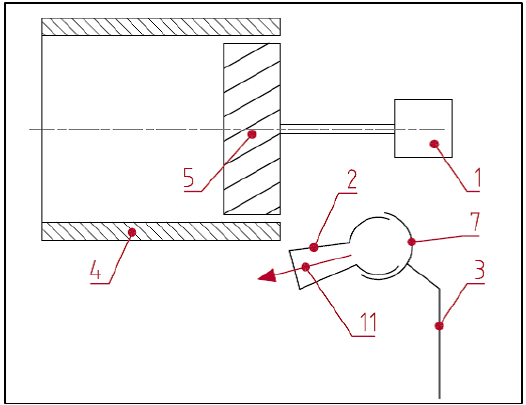
Figure 17. Schematic of a hybrid mesh turbine when switching the operating mode: 1- generator; 2- nozzle block; 3- working gas source; 4- casing; 5- impeller; 7- velocity vector control system; 11- working fluid flow.